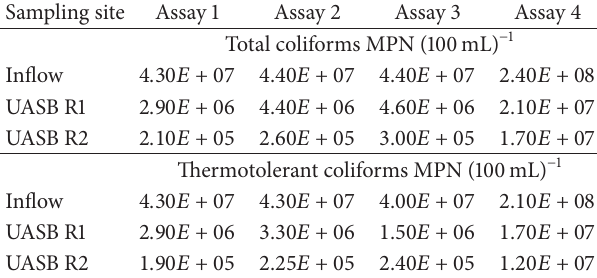
Table 2: Average values of the most probable number of total and thermotolerant coliforms in the inflow and effluents of UASB reactors (R1 and R2) placed in series of treatment system I, in assays 1, 2, 3, and 4.